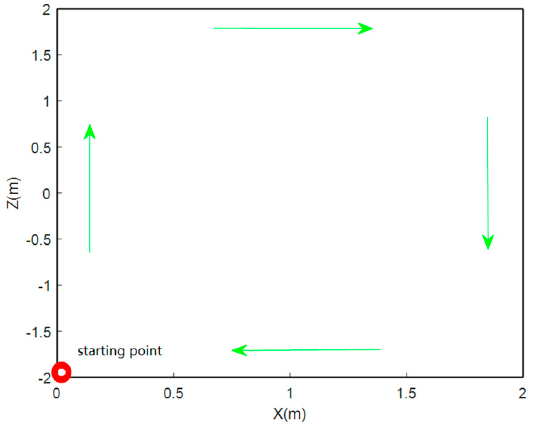
Figure 17. Reference trajectory of the dynamic experiment.